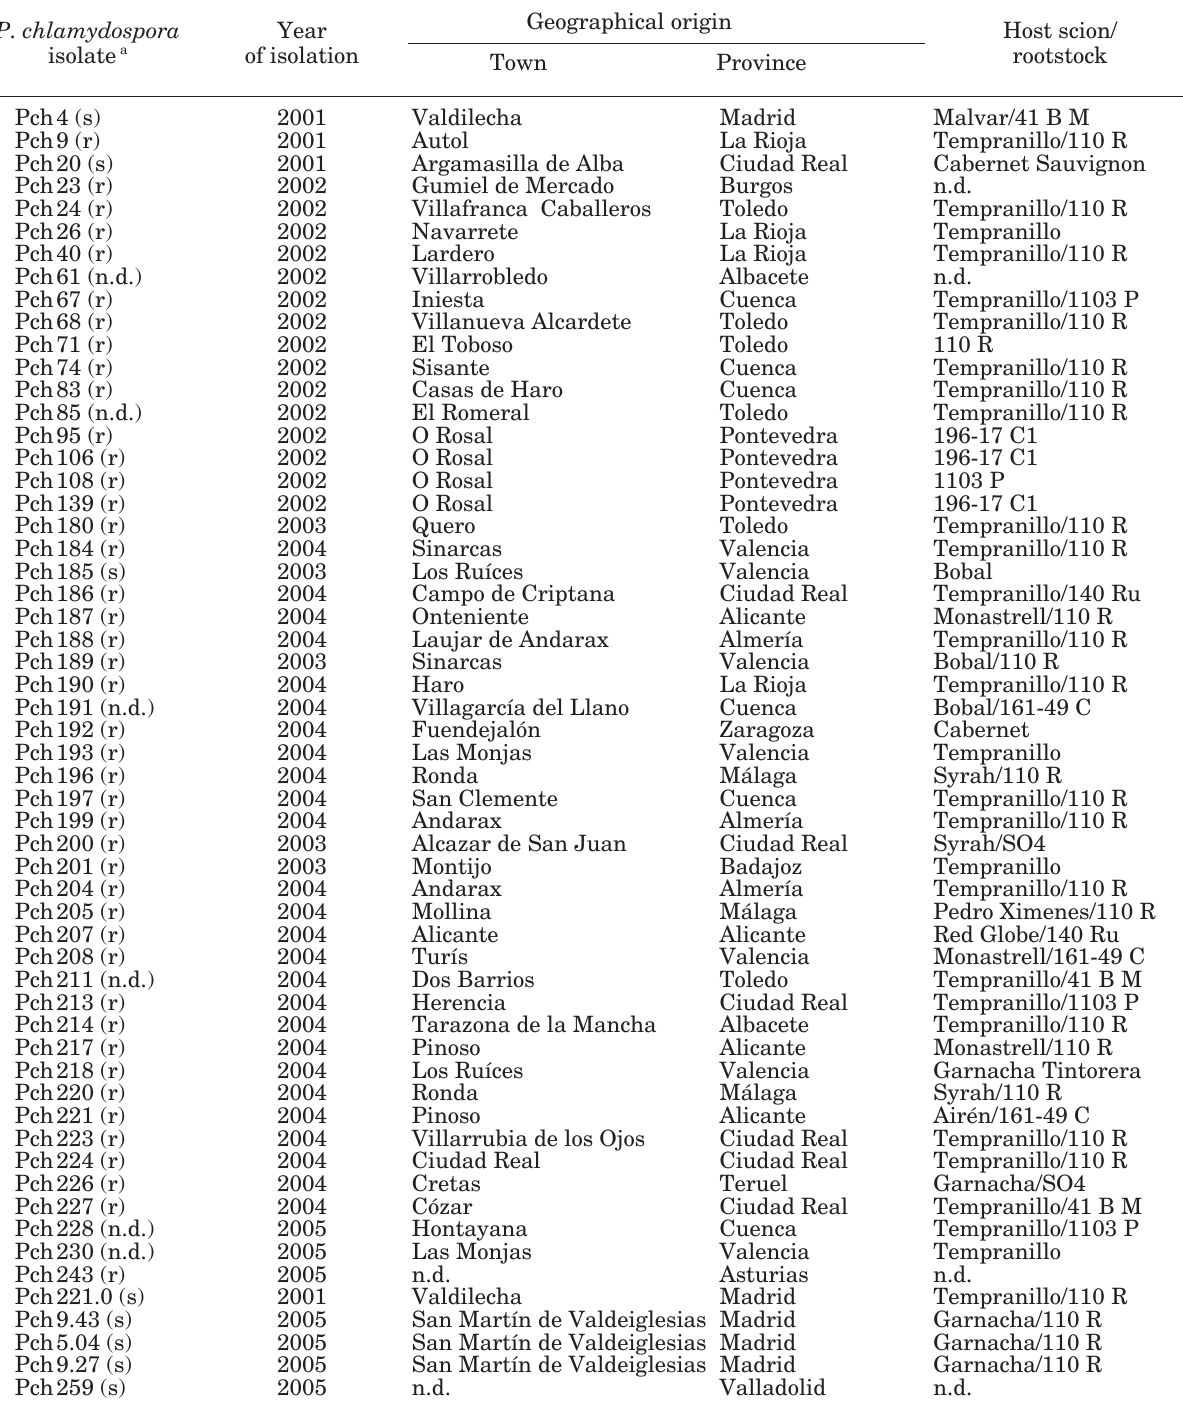
Table 1.- Spanish P. chlamydospora isolates employed in the present study. P. chlamydospora isolate